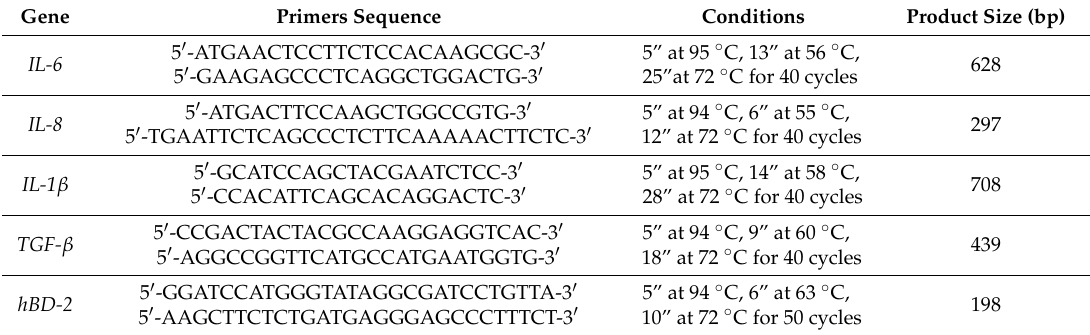
Table 1. Primers